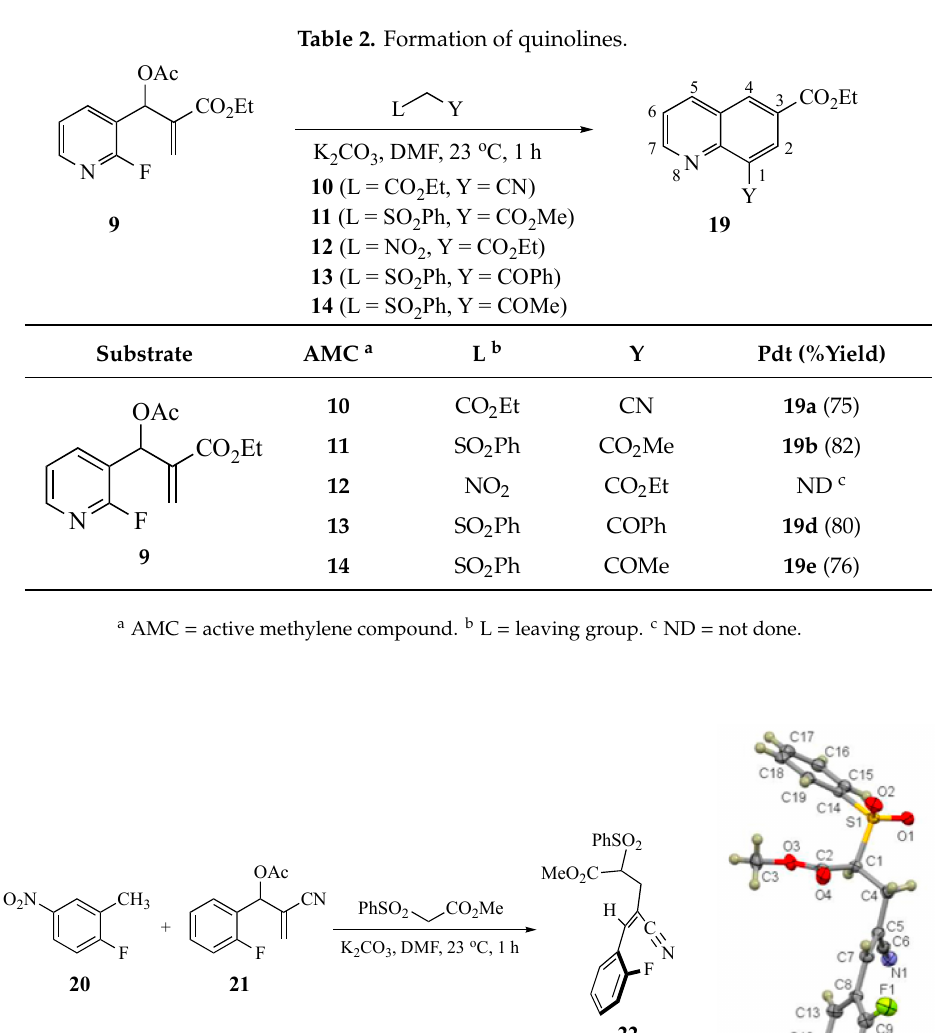
Figure 2. Conformation of an MBH alcohol with a stabilizing H ‐ bond. In reactions at the side chain allylic moiety, there are two possible scenarios to explain the addition to the MBH acetate. The first [22] invokes an S N 2 ′ process where a nucleophile attacks C1 (unsubstituted) of the allylic moiety, resulting in an accumulation of electron density on the opposite face of the molecule at C2. Then, this electron density is responsible for assisting in the departure of the acetoxy leaving group at C3. This process has been used to rationalize the reported preference for a syn orientation between the incoming nucleophile and the leaving group often seen in the reaction [23–25], although exceptions are known [26] with certain Nu – /L – combinations. The second scenario [27] claims that there is no justification for a syn orientation between the nucleophile and the leaving group. In fact, in highly substituted derivatives, such as 5 – 9 , it has been suggested that the formation of a stabilized carbocation is more likely, in which case the avoidance of steric interactions guides the transformation to give the final product stereochemistry. The S N 2 ′ initiated mechanism is depicted in Scheme 3 for the reaction of 6 with 11 to give 16b . The initial conformation of 6 would allow minimal steric interaction between the groups on the